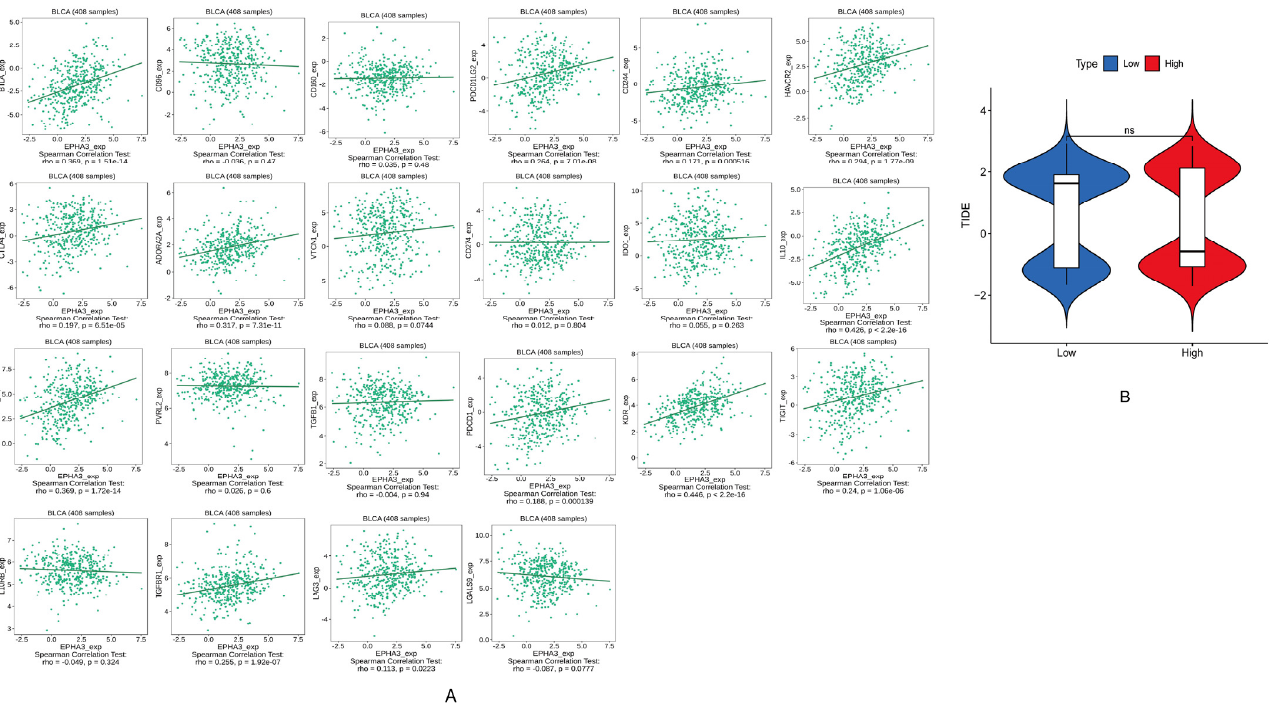
Figure 14. ( A ) Scatter plots indicate the correlation of EPHA3 level with 22 immune checkpoint genes (ICGs). ( B ) The violin plot indicates the association between the TIDE score and high and low EPHA3 expression groups in TCGA-BLCA.